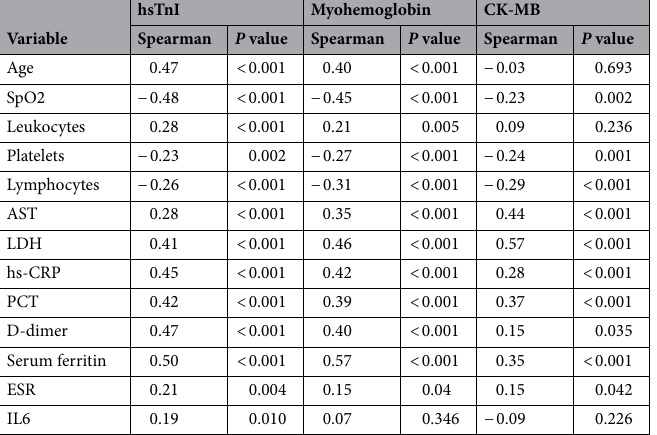
Table 4. Spearman correlation analysis between cardiac biomarkers and other laboratory